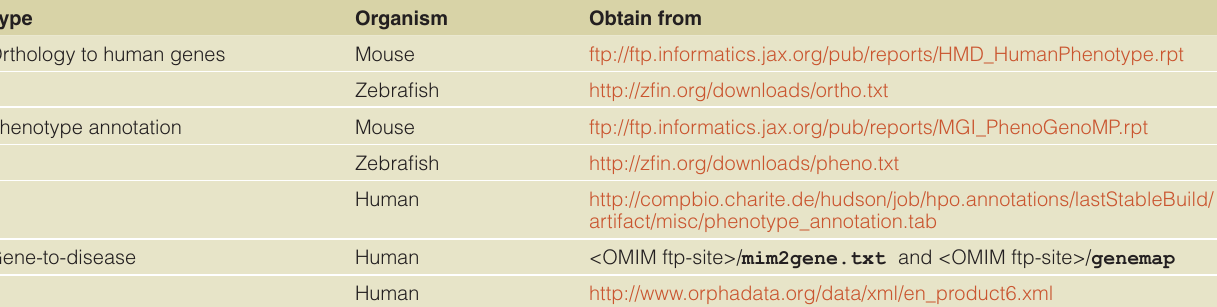
Table 2. Files required to connect genes and phenotypes as well as to get the orthology relationship between model organism genes and human genes. These files are especially important for Step 4 in Figure 2 .